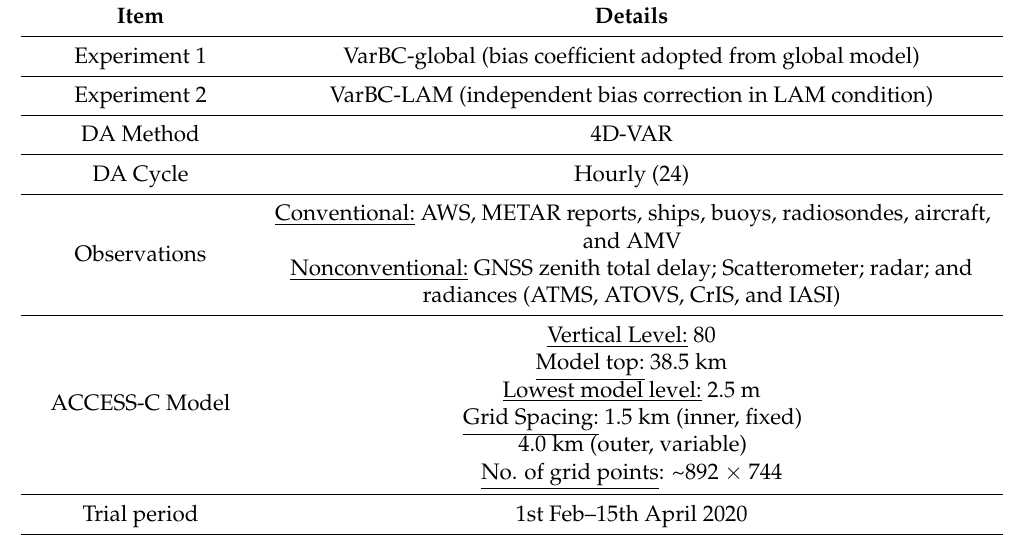
Table 1. Experiment details.